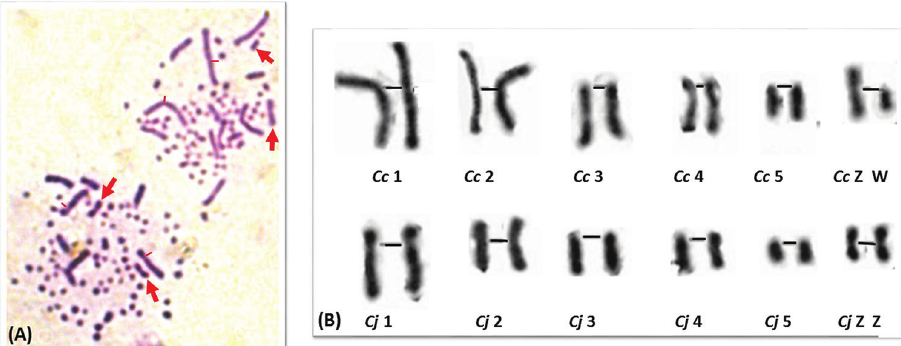
Figure 6. Chimera embryo showing A the cohabitation of the Common and Japanese quail cells B gynandromorphism corresponding karyotypes to A with ZZ/ZW chromosomes indicated by the